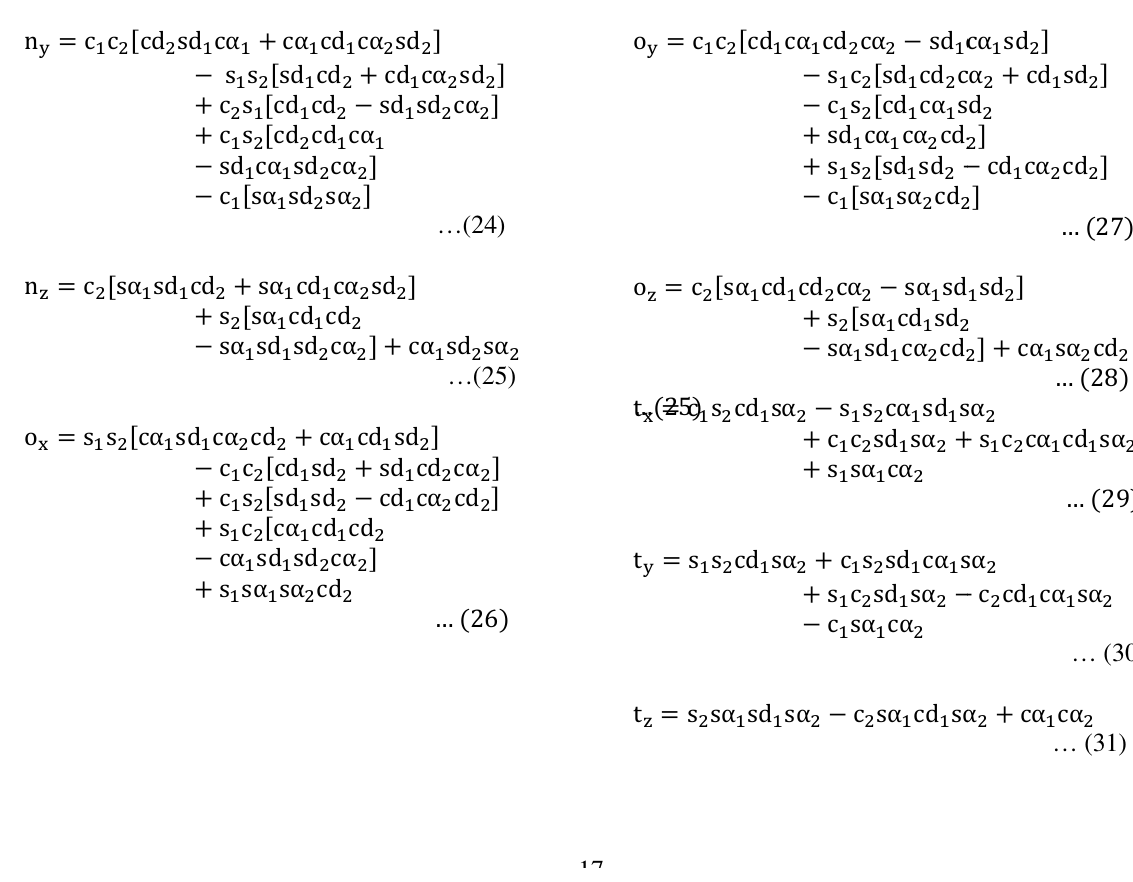
Fig. 4. the coordinates systems of two elastic links and the angles of joints the coordinates systems of two elastic links and the angles of